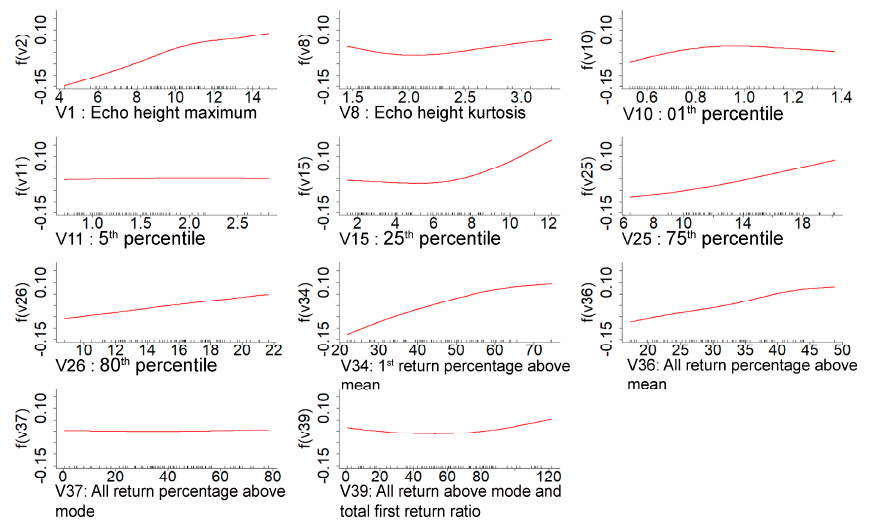
Figure 5. Each panel shows the relationship of the variable with nonzero coefficients (Xaxis) in the GAMSEL model for basal area estimation with the functions for the last value of the lambda (Y-axis).